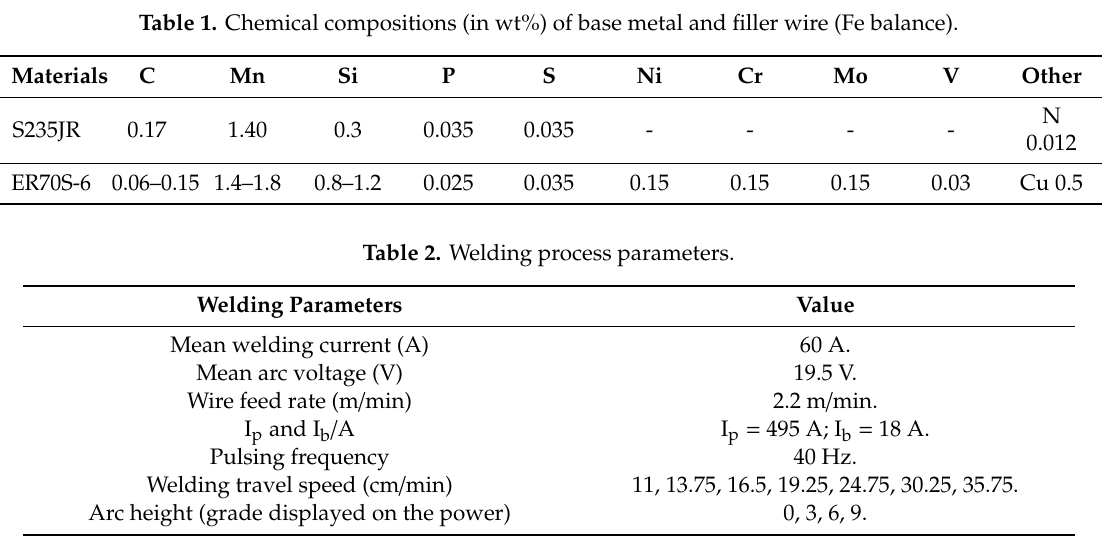
Figure 2. Experimental system and image processing system.